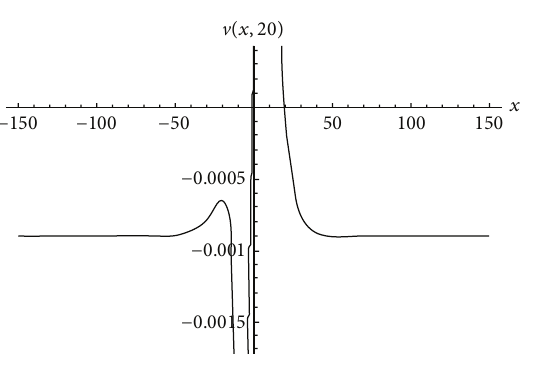
Figure 3: Approximate solution of FWBK equation.